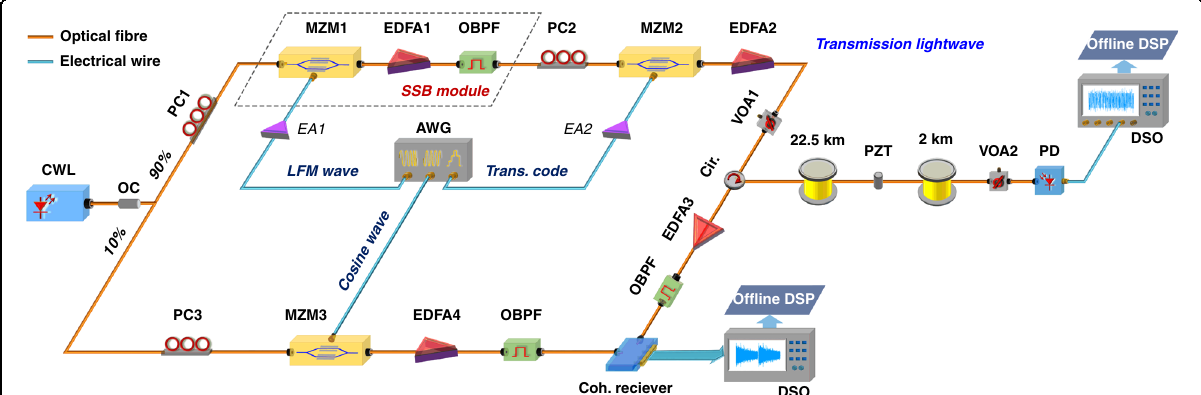
Fig. 2 Experimental setup for the integrated sensing and communication in an optical fi bre. CWL continuous-wave laser, OC optical coupler, PC polarization controller, MZM Mach-Zehnder modulator, EDFA erbium-doped fi bre ampli fi er, OBPF optical bandpass fi lter, EA electrical ampli fi er, AWG arbitrary waveform generator, VOA variable optical attenuator, Cir circulator, PZT piezoelectric transducer, PD photodetector, DSO digital storage oscilloscope, DSP digital signal